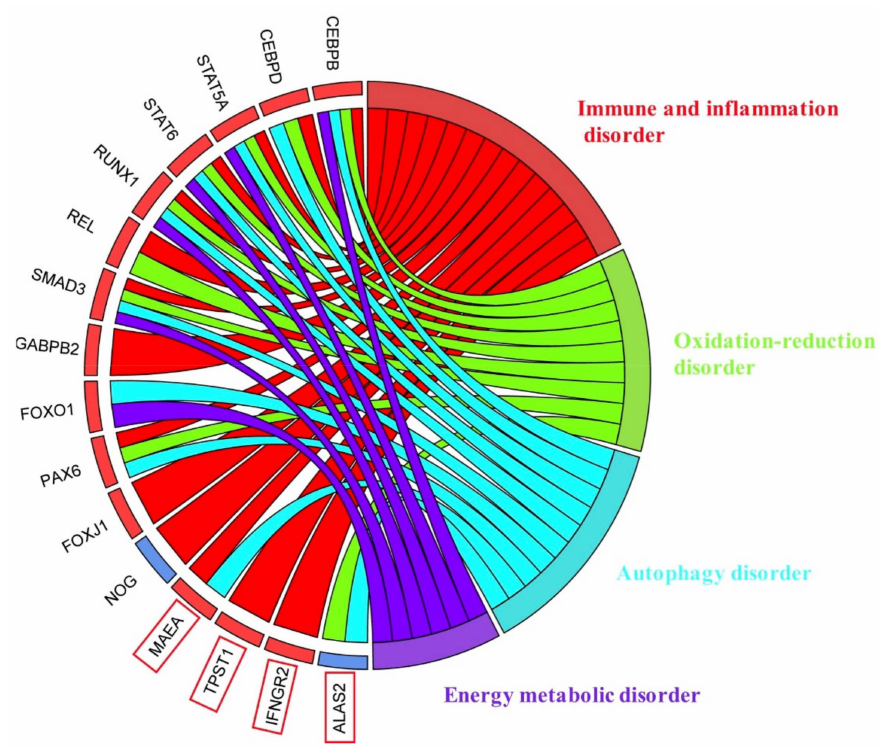
Figure 12. Summary of the relationship between 12 important transcription factors, 4 important survival-related markers and the potential pathogenic mechanism of